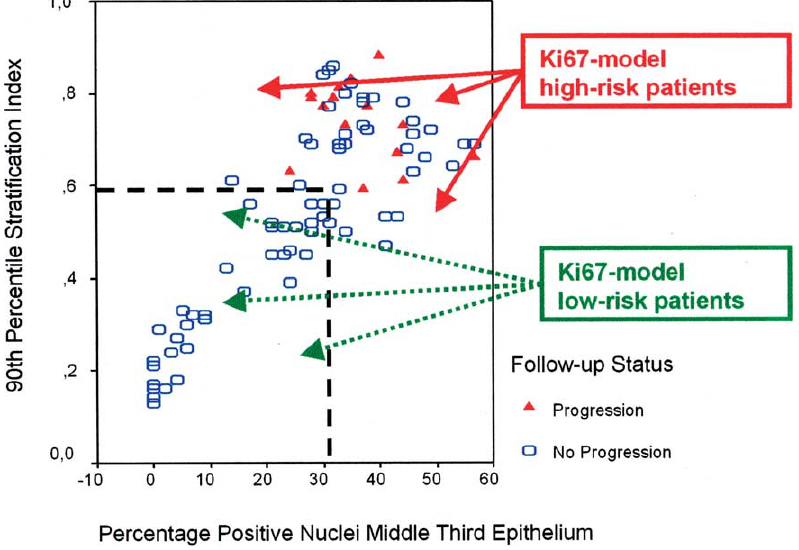
Fig. 2. Progression based on 90th percentile of the stratification index against the percentage Ki67 positive nuclei in the middle third layer of the cervical